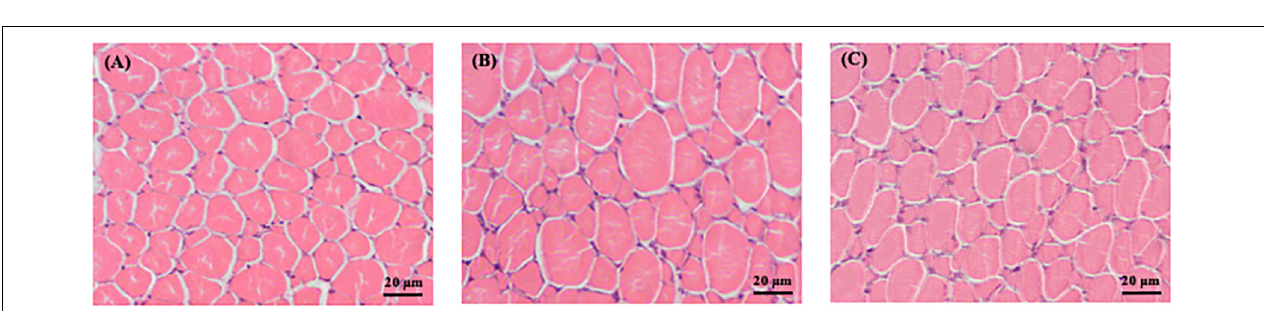
FIGURE 2 | Transversal cross-section area of skeletal muscle fast-twitch fibers of Senegalese sole, at 70 DAH, of the different treatments (A) CTRL, (B) CC, and (C) GS. Magnification: 400x. Scale bars: 20 µ m.